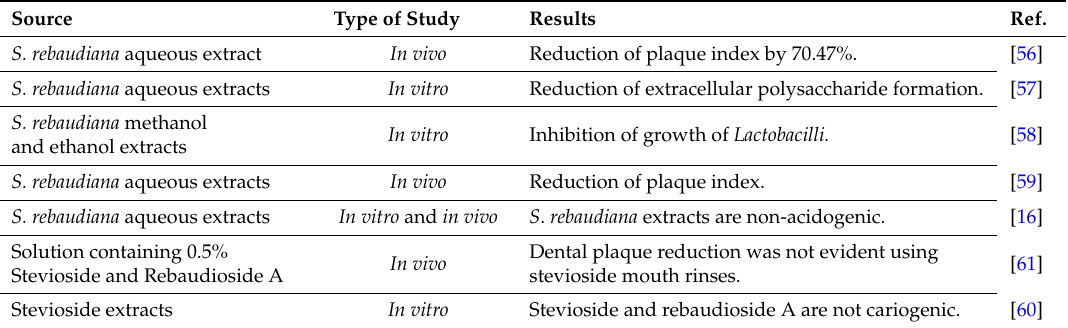
Table 4. Caries prevention activity of S. rebaudiana extracts and steviol glycosides.